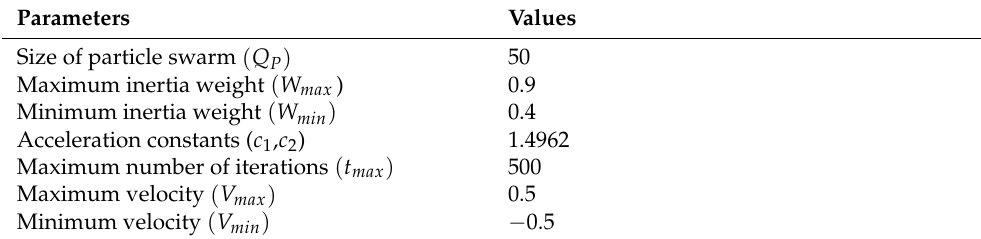
Table 2. Design Parameters of PSO.